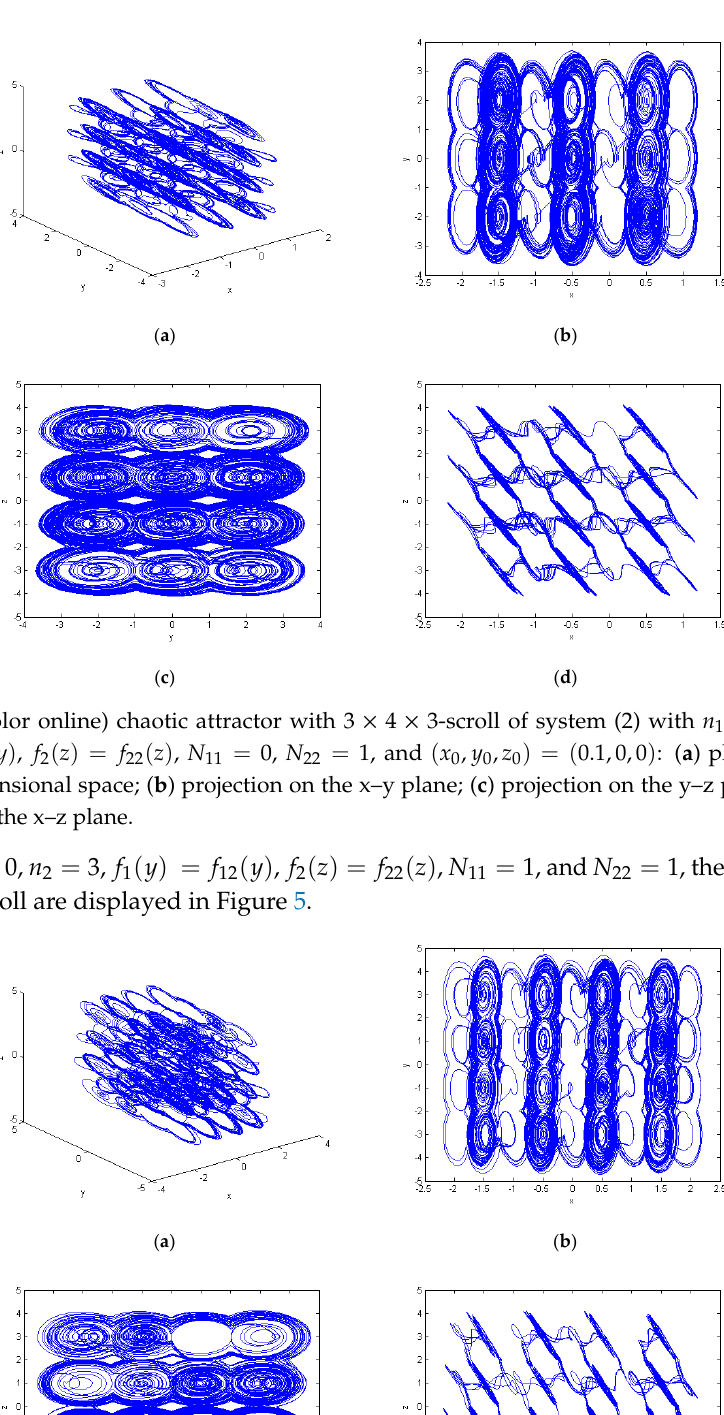
( d ) Figure 3. (Color online) chaotic attractor with 3 × 4 × 3-scroll of system (2) with 1 1 n = , 2 2 n = , ( )